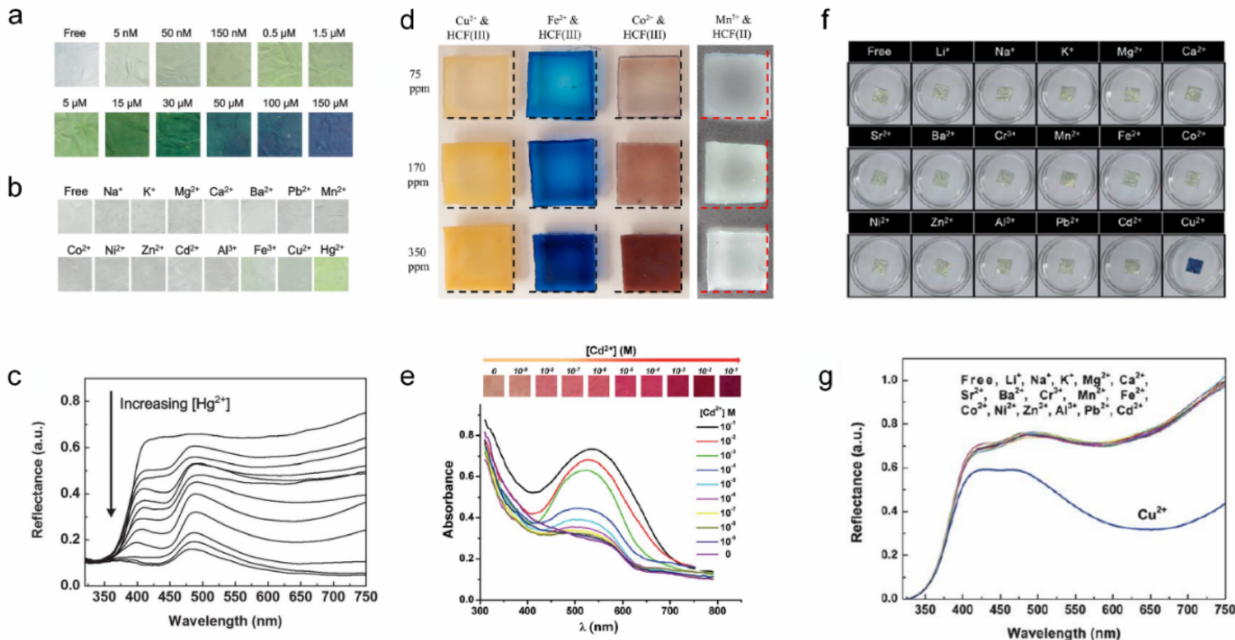
Figure 8. Ion responsive chromic device (( a – c ) adapted with permission from ref. [102], copyright 2014 The Royal Society of Chemistry, ( d ) adapted with permission from ref. [103], copyright 2018 Elsevier, ( e ) adapted with permission from ref. [105], copyright 2014 The Royal Society of Chemistry, and ( f , g ) adapted with permission from ref. [106], copyright 2011 The Royal Society of Chemistry). ( a ) Gradual colorimetric change of the PANI-LB under Hg 2+ exposure in an aqueous solution. ( b ) Selectivity test conducted by exposing the PANI-LB to 5 µ M of various metal ion solutions. ( c ) Reflectance in visible spectra with increasing concentration of Hg 2+ . ( d ) Photographs of color- changed hydrogels exposed to various transition metal ions. Swelling and deswelling of the gels can be detected in comparison with the dash lines corresponding to 3 × 3 cm 2 . ( e ) Images of color gradient and UV-vis absorbance spectra of SiO 2 and DPC-doped fibrous films under different Cd 2+ ion concentrations. ( f ) Photographs and ( g ) reflectance spectra displaying the selectivity of the fabricated membranes in various metal ions with the concentration of 1